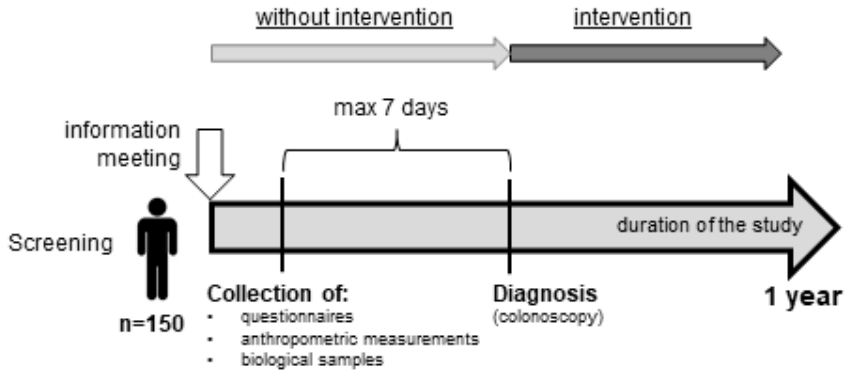
Figure 1. Time-based study Figure 1. Time ‐ based study design.